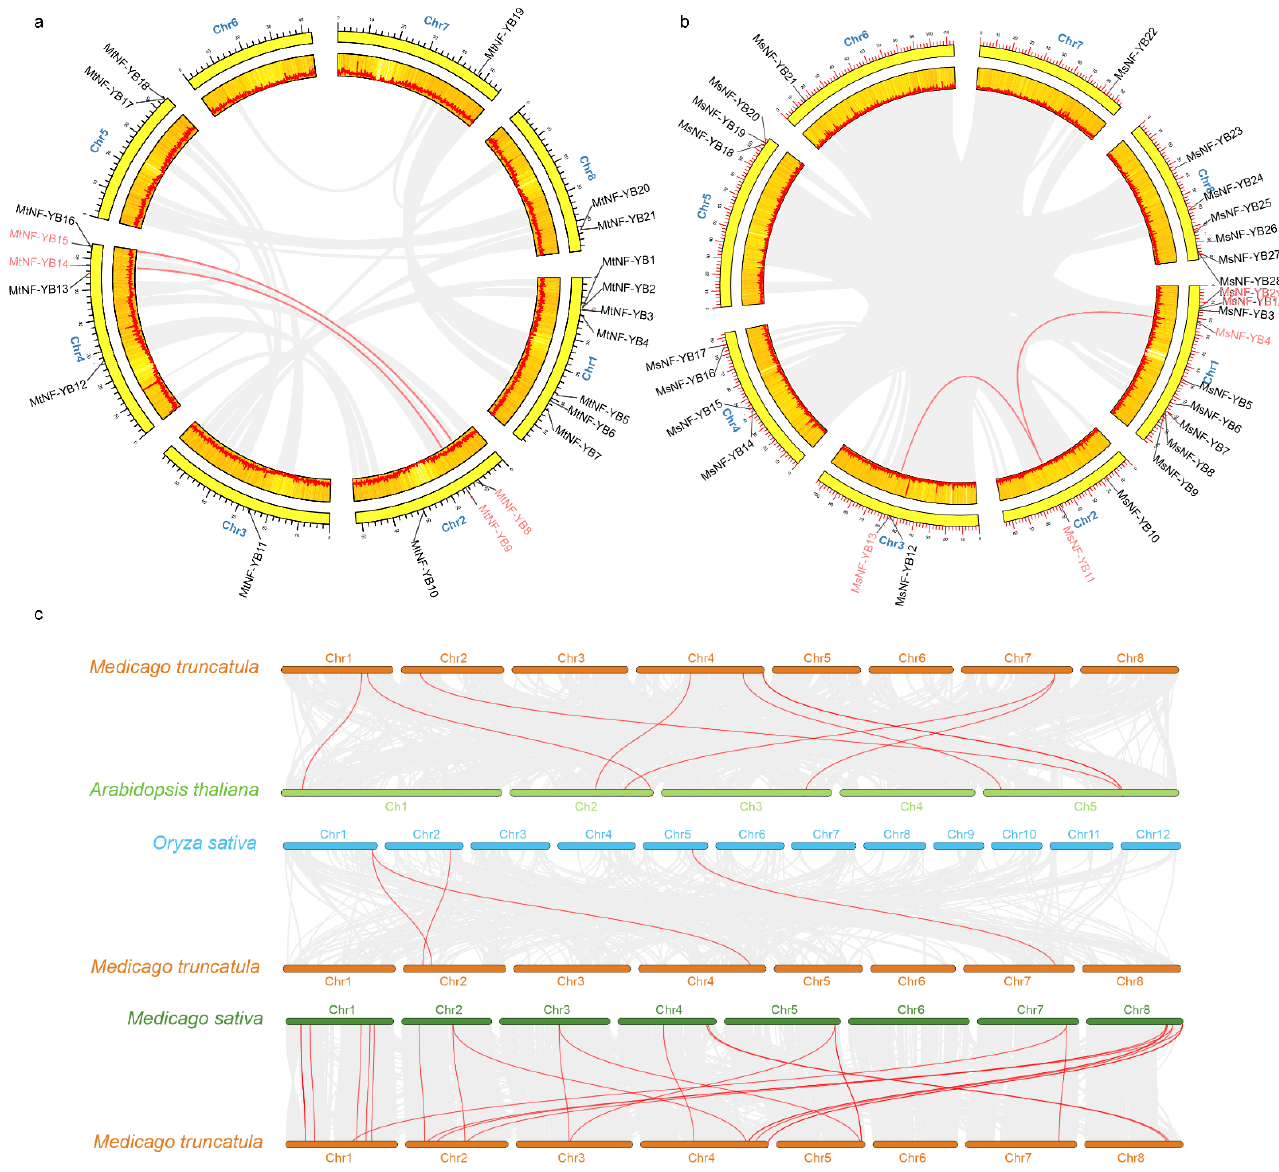
Figure 4. Chromosome distributions of NF-YBs in M. truncatula and M. sativa . The chromosomal location and interchromosomal relationship of M. truncatula ( a ) and M. sativa ( b ). The segmentally duplicated and tandem duplicated genes are connected by red curves. ( c ) Synteny analysis of NF-YB genes between A. thaliana and M. truncatula , O. sativa and M. truncatula , M. sativa and M. truncatula . Gray lines in background indicate the collinear blocks between M. truncatula and A. thaliana / O. sativa / M. sativa , and red lines highlight syntenic NF-YB gene pairs.